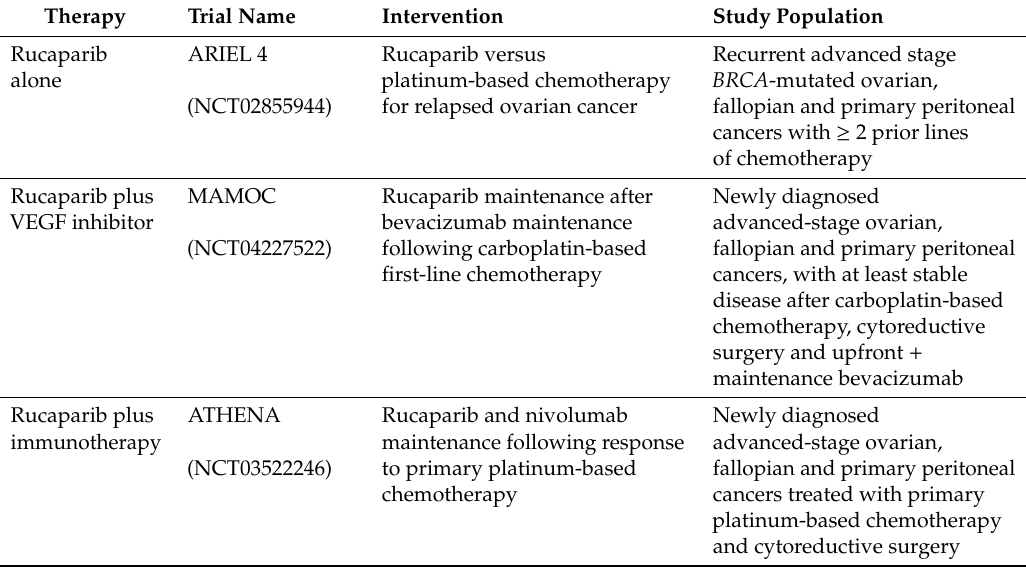
Table 3. Ongoing phase 3 trials of rucaparib monotherapy or combination